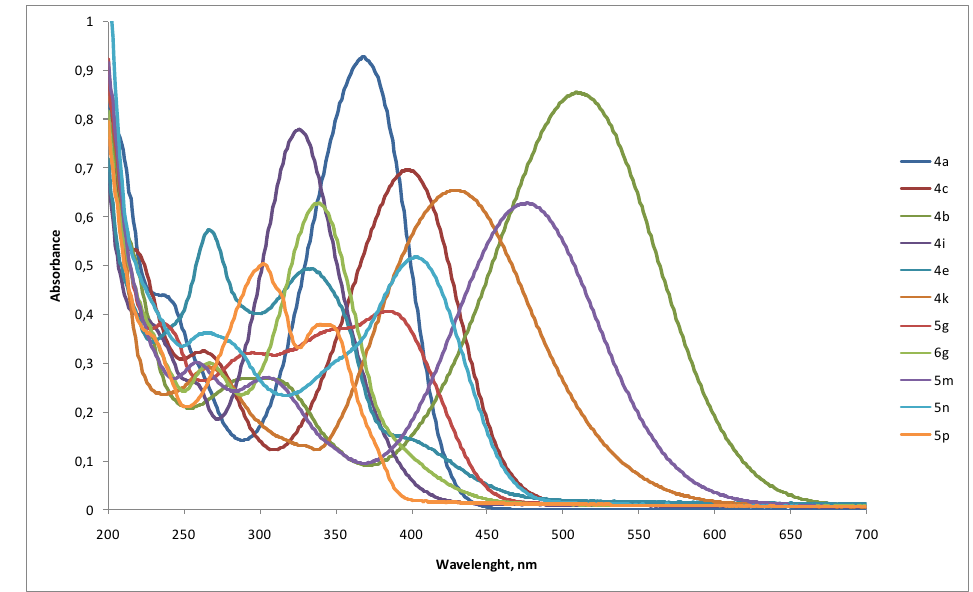
Figure 4. X-ray crystal structures of compounds 5h (left) and 5l (right) with thermal ellipsoids at 50% probability level.